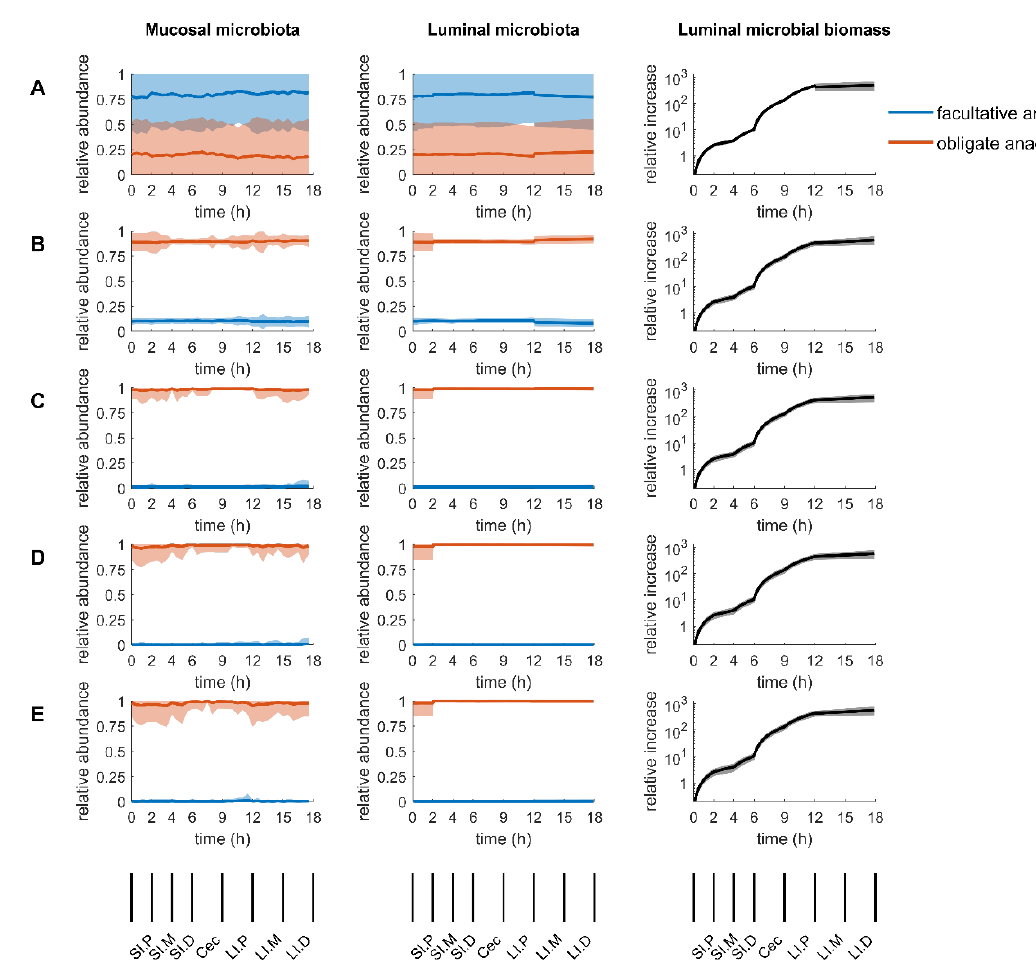
Figure 8. Varying the total oxygen available to the gut microbiota 𝑟 𝑜𝑥𝑦𝑔𝑒𝑛𝑡𝑜𝑡𝑎𝑙 such that the oxygen-per- mucosal-biomass availability 𝑟 𝑜𝑥𝑦𝑔𝑒𝑛𝑡𝑜𝑡𝑎𝑙 /𝑋 𝑚𝑢𝑐𝑡𝑜𝑡𝑎𝑙 remains constant along the intestines in each simulation as detailed in Table 4. ( A ) 2.4 mmol gdw −1 h −1 . ( B ) 0.24 mmol gdw −1 h −1 , same as the default value in the proximal small intestine. ( C ) 0.024 mmol gdw −1 h −1 . ( D ) 0.0024 mmol gdw −1 h −1 , close to the default value in the proximal large intestine. ( E ) 0.00024 mmol gdw −1 h −1 .